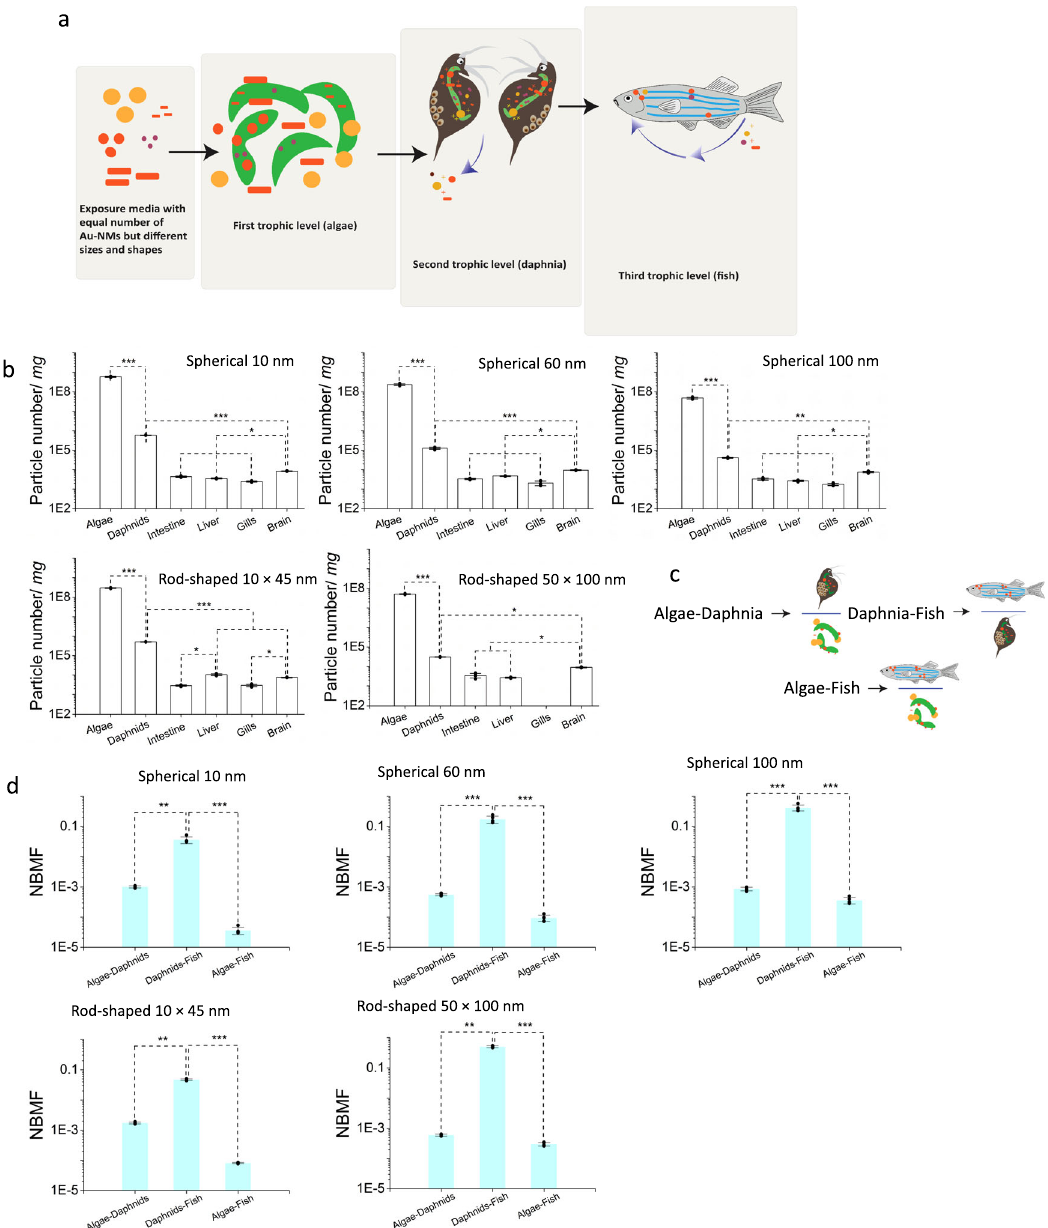
Fig. 3 The number of Au-NMs at each trophic level. a Schematic representation of the trophic transfer of NMs based on particle number. Despite being exposed to the same number of Au-NMs, algae accumulate (associated with the cell or internalized in the cells) different numbers of Au-NMs as a function of NM size and shape. Smaller numbers of the Au-NMs accumulate in the daphnids compared to the algae. The NMs undergo dissolution and aggregation in the daphnids gut as a function of the NM properties, which changes the size distribution of the NMs accumulated in the daphnids. A high percentage of the NMs are excreted from the daphnids and only a small fraction is transferred to the fi sh. No particle number-based biomagni fi cation occurs in fi sh. However, the number of accumulated NMs in fi sh is a function of the initial NM size and shape. The biodistribution of the Au-NMs in fi sh was also NM size- and shape-dependent, where a higher number of particles were detected in the brain compared to other tissues. b Particle number (per mg wet weight tissue) of Au-NMs accumulated at each trophic level (algae, daphnids, and fi sh tissues) as a function of NM size and shape. c Schematic representation of the trophic transfers (Algae – Daphnia, Daphnia – Fish, and Algae – Fish) considered to calculate the number-based biomagni fi cation factors (NBMF). d The calculated NBMFs of the Au-NM in the different trophic levels of the assembled food chain used in this study. Note that the trophic transfer of Algae – Fish was calculated by dividing the total number of the particles in fi sh by the total number of the particles in algae, although the fi sh was not fed with algae directly (** P < 0.001, *** P < 0.0001). S: spherical, R-s: rod-shaped. Error bars = SD, biologically independent samples ( n = 5). Data